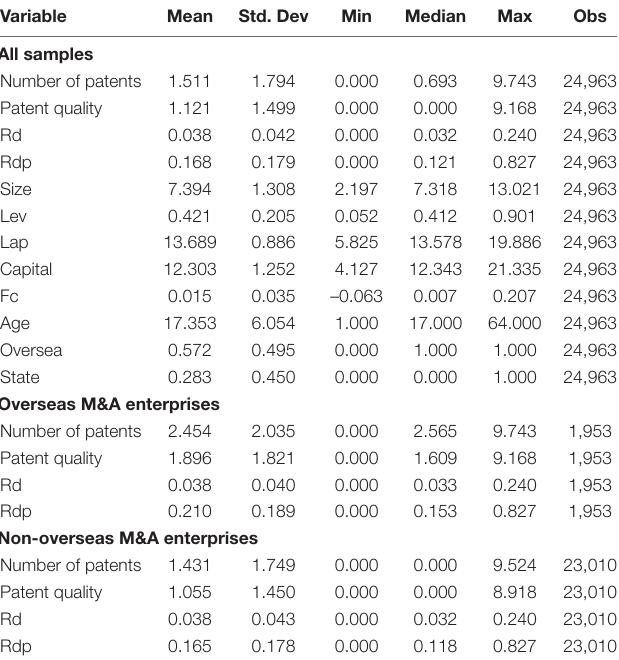
TABLE 2 | Descriptive statistics of all